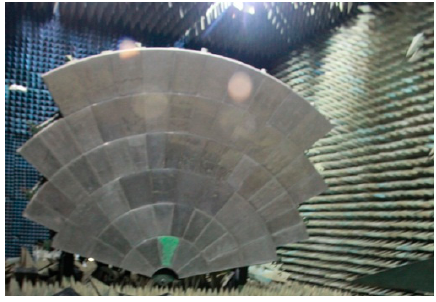
Figure 16. The reflector. Figure 17. The reflector.